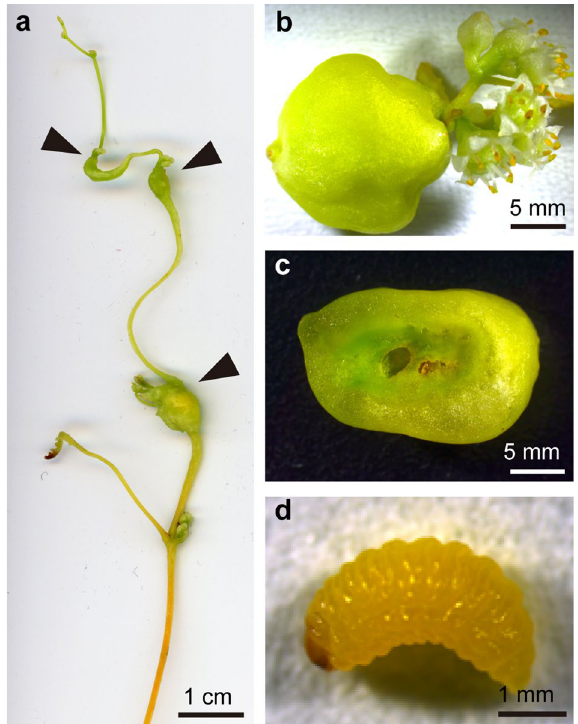
Figure 1. Smicronyx madaranus -induced galls on Cuscuta campestris . ( a ) Galls formed at branching points on a shoot, ( b ) a gall formed at the base of an inflorescence. ( c ) transverse section of a mature gall, ( d ) S. madaranus larva inhabiting a mature gall. Arrow head,